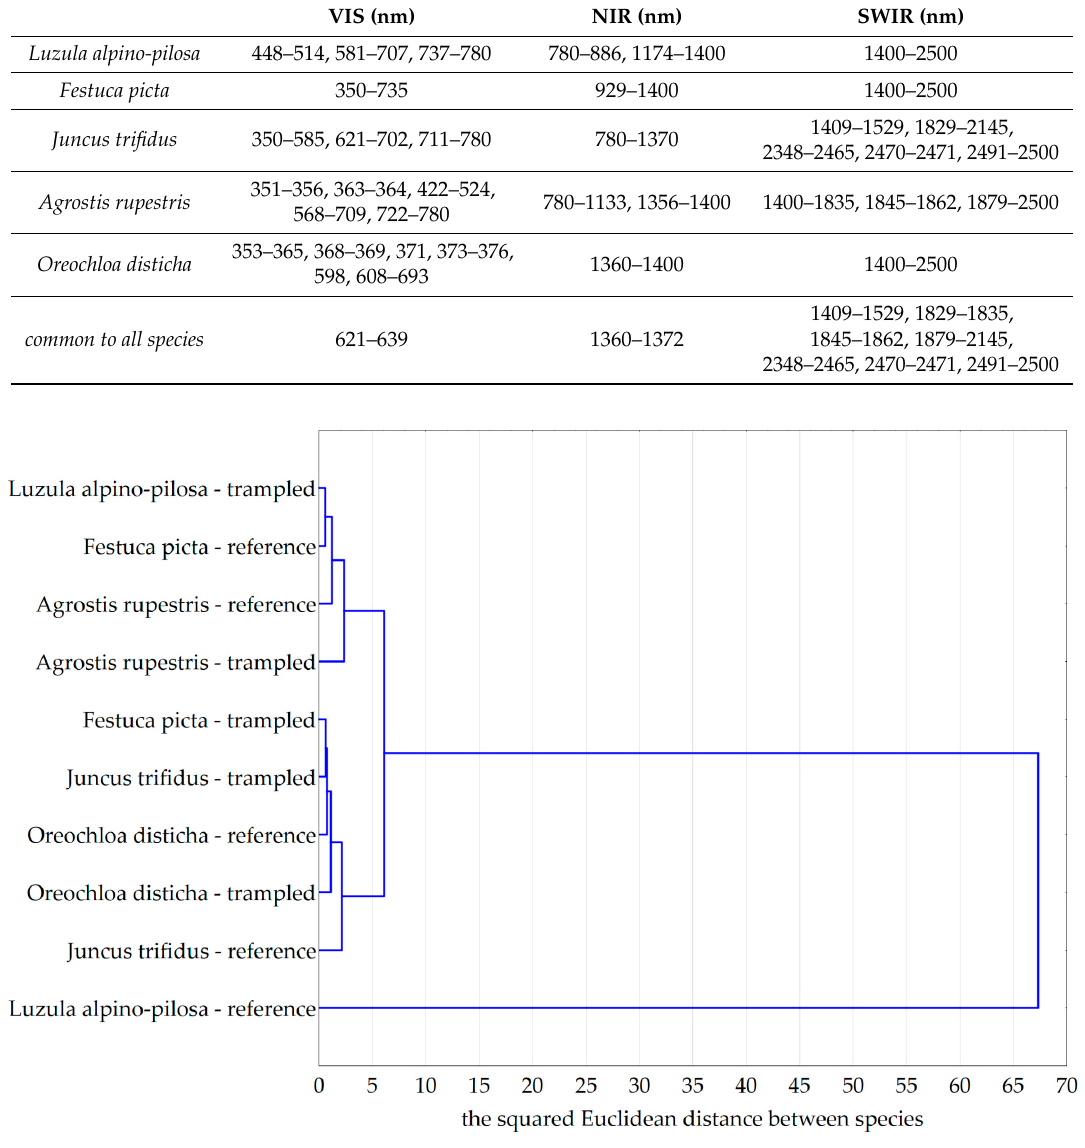
Figure 5. Agglomeration of spectral reflection curves in the electromagnetic spectrum (350–2500 nm; Ward’s method).